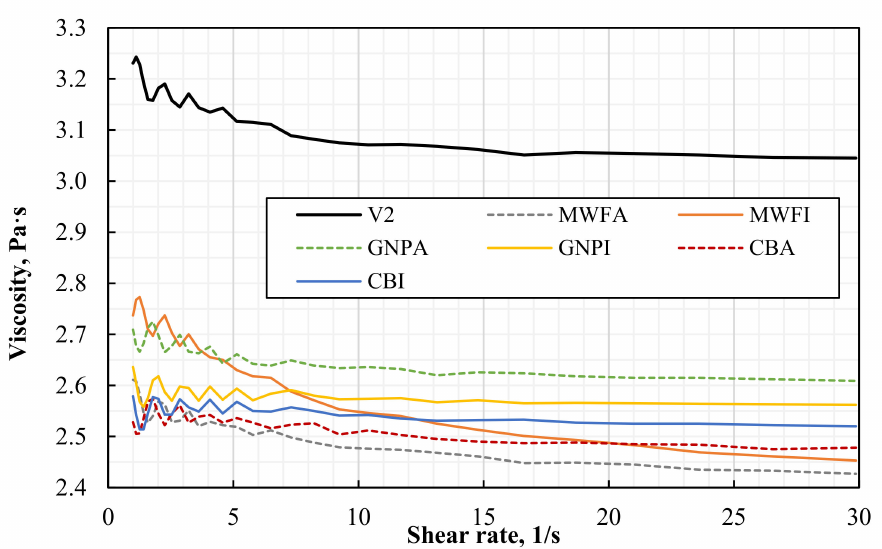
Figure 13. Viscosities of 0.1 wt.% nanomaterial/photopolymer composites and pristine “High- Temperature V2” photopolymer resin at shear rates from 1 to 30 s − 1